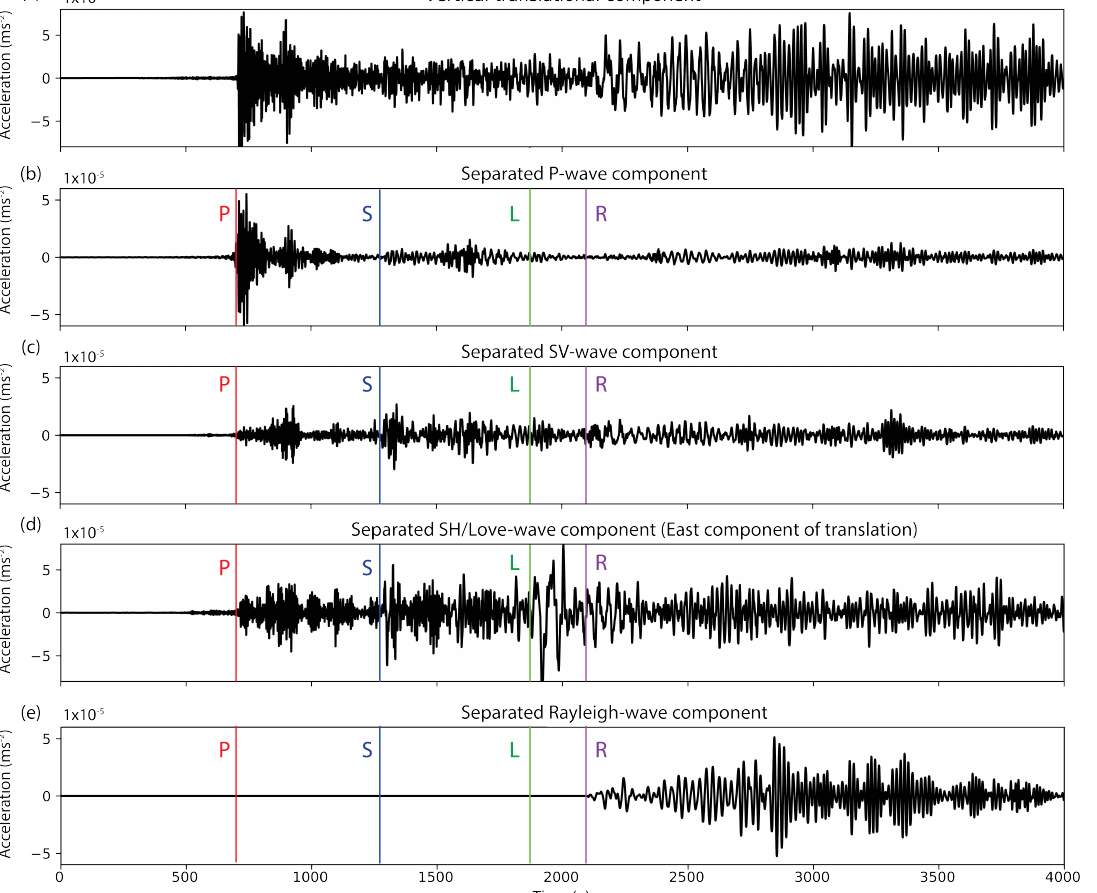
Figure 6. Single-station 6DOF wave-mode filtering applied to the gulf of Alaska earthquake. The automatic wave-mode classification of different arrivals shown in Figure 5 can be used to filter the data to yield wave-type specific seismograms. The original vertical component of translational motion is displayed in ( a ). The panels ( b – e ) show the output of the proposed wave-mode separation filters for P-waves ( b ), SV-waves ( c ), SH-/Love waves ( d ), and Rayleigh waves ( e ). Colored lines mark arrival times of some key phases obtained from ray